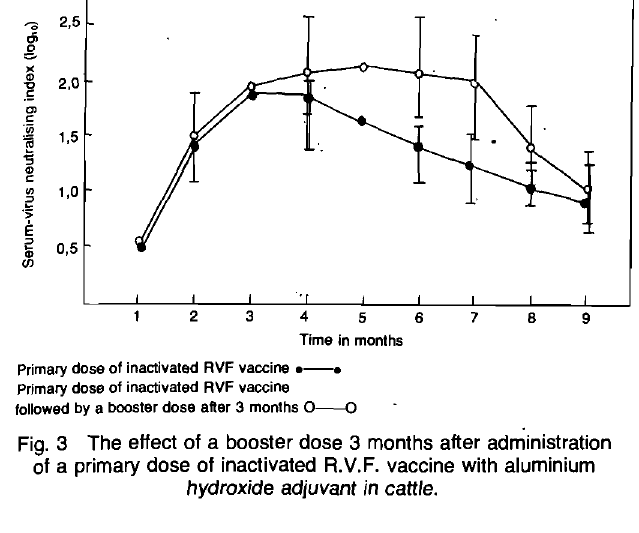
Fig. 3 The effect of a booster dose 3 months after administration of a primary dose of inactivated R.V.F. vaccine with aluminium hydroxide adjuvant in cattle.